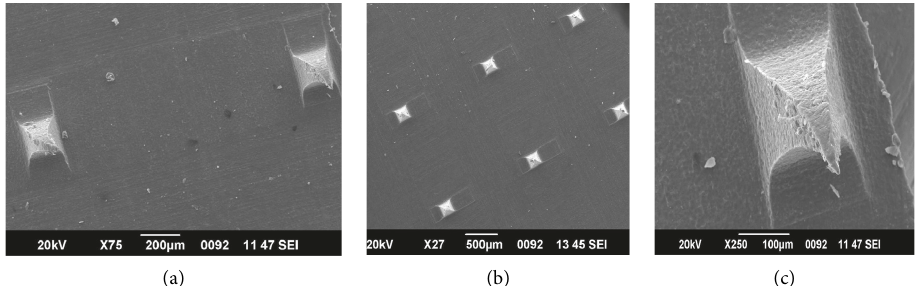
Figure 8: SEM images of (a) shape of drug-loaded microneedle patch, (b) needle to needle distance, and (c) the base diameter and height of microneedle.